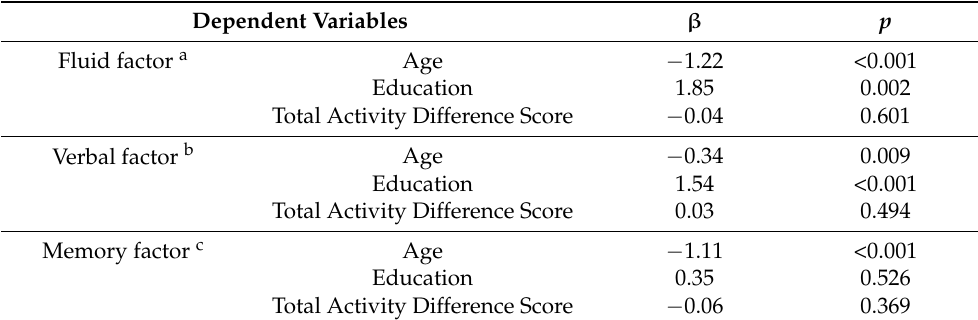
Table 5. Multivariate Multiple Regression Standardized Coefficients of Total Activity Difference Score, Age, and Education Predicting Cognitive Factors.